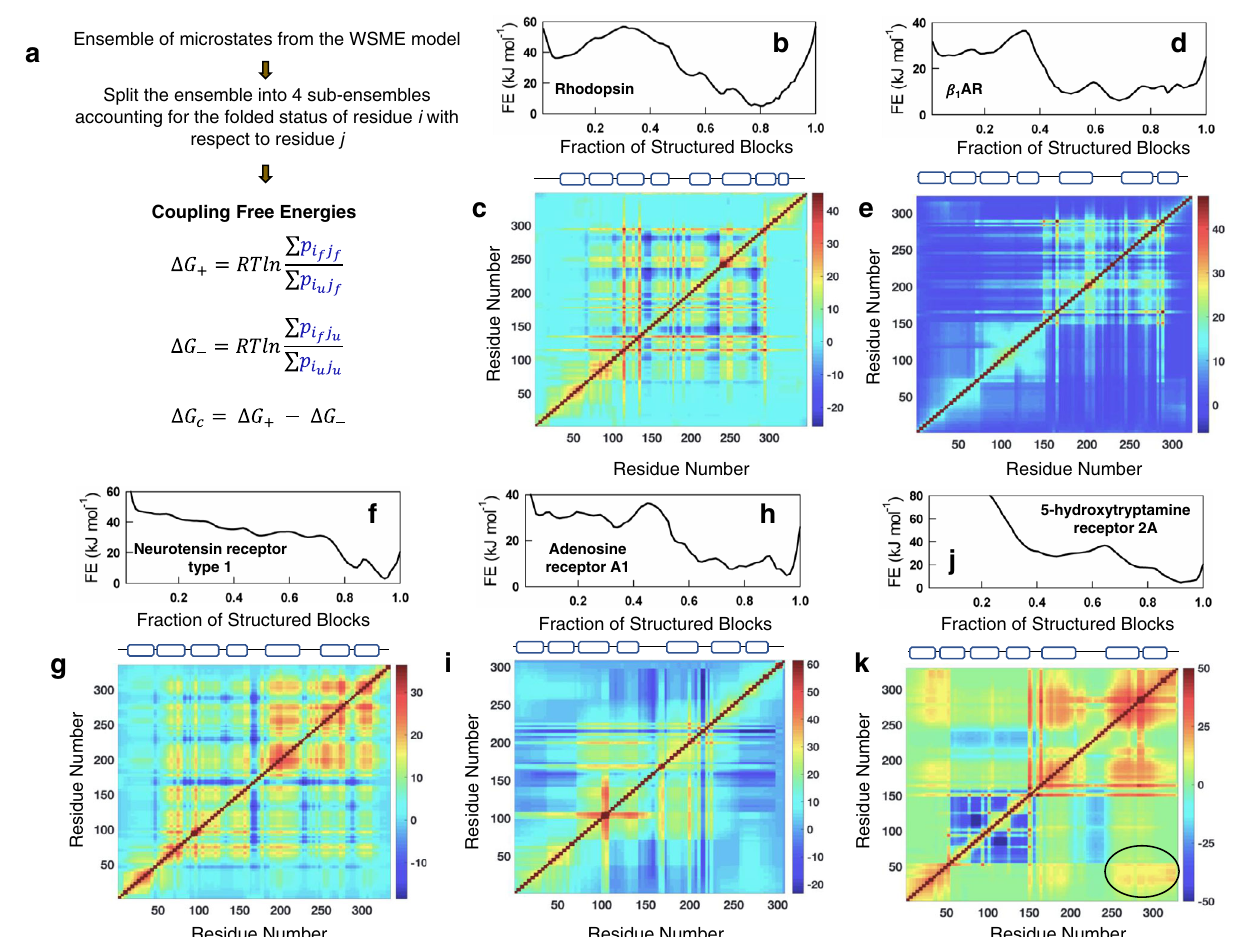
Fig. 4 | Thermodynamic architecture of GPCRs. a A fl ow chart describing the methodology employed to calculate coupling free energies from the microstate populations. b , d , f , h , j One-dimensional free energy pro fi les at 310K. c , e , g , i , k The corresponding effective coupling free energy ( Δ G c ) matrices. The color bars are in the spectral scale and in units of kJmol − 1 , with dark red and dark